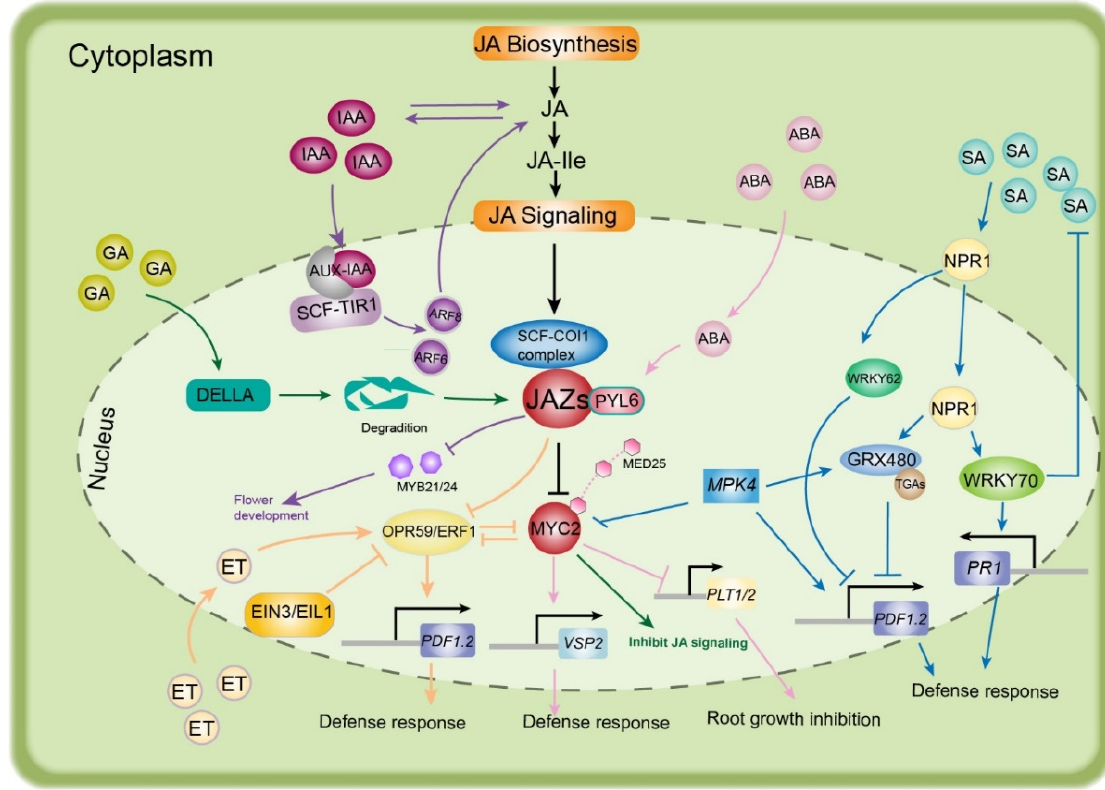
Figure 5. An integrated view of JA biosynthesis and signaling, including signaling interactions of JA with auxin, GA, SA, ET, and ABA in plant responses to stresses. See the text for further details. Lines of different colors represent the pathways of specific hormones. Abbreviations: SA, salicylic acid; NPR1, non-inducible PR1; GRX480, redox regulators glutathione; TGAs, TGACG-binding factors. PR1, pathogenesis-related protein 1; PDF1.2, plant defensin 1.2; MPK4, Mitogen-activated protein kinase 4; ABA, abscisic acid; PYL6, abscisic acid receptor; MED25, mediator 25; PLT1/2, plethora 1/2; VSP2, vegetative storage protein 2; ET, ethylene; OPR59, octadecanoid-responsive Arabidopsis AP2/ERF-domain protein 59; ERF1, ethylene response factor 1; EIN3, ethylene insensitive 3; EIL1, EIN3-like1; GA, gibberellic acid; IAA, indole acetic acid; AUX-IAA, auxin/Indole-3-acetic acid; SCF, [kinetochore protein 1 (SKP1)-CULLIN1 (CUL1)-F-box]; COI1, coronatine insensitive1; TIR1, transport inhibition response1; ARF6, auxin response factor 6; ARF8, auxin response factor 8; JA, jasmonic acid; JA-Ile, jasmonic acid isoleucine conjugate; JAZ, jasmonate ZIM